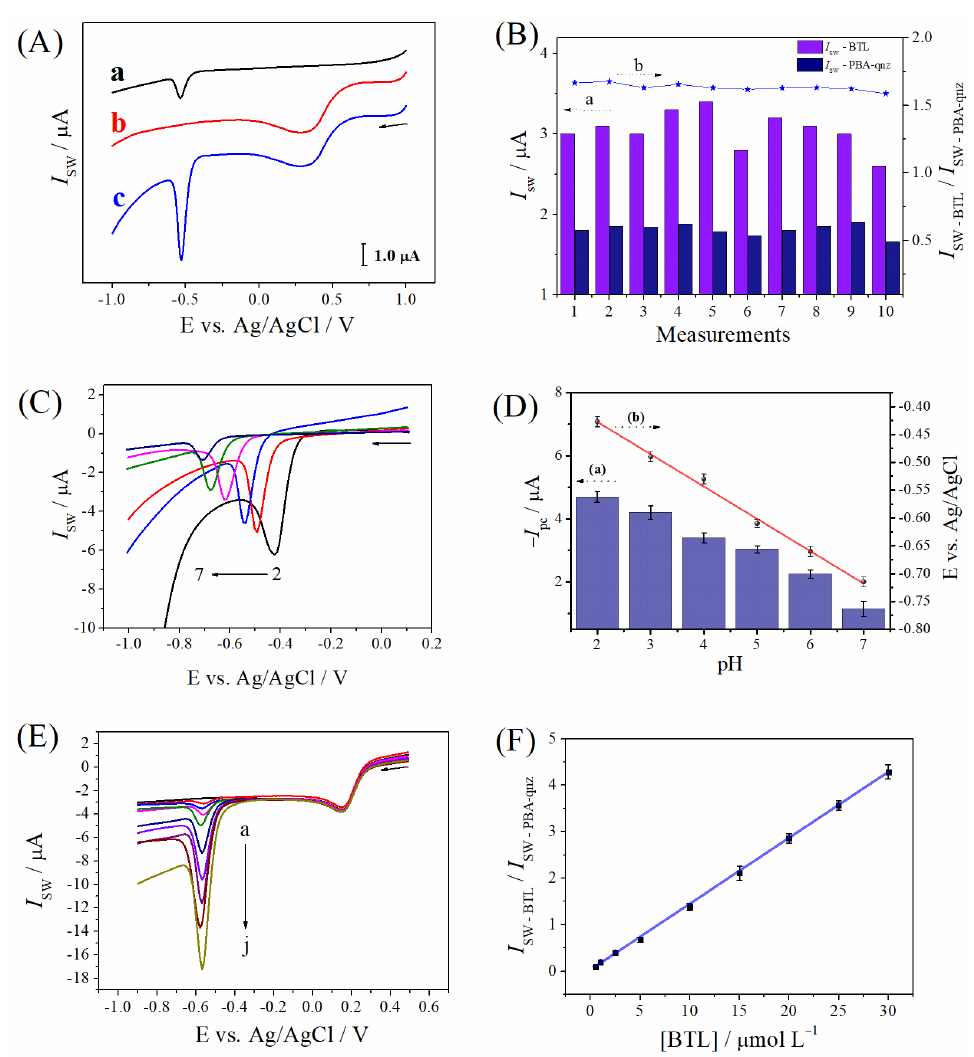
Figure 4. ( A ) Square wave voltammograms in the absence of BTL for (b) PBA-qnz/CPE in buffer solution and in the presence of 10.0 μmol L −1 BTL in B – R buffer (pH 2.0) for (a) CPE and (c) PBA-qnz/CPE. SWV parameters: f = 25.0 Hz, ΔEs = 1.0 mV, a = 50.0 mV (nonoptimized). ( B ) Current responses for I SW − BTL and I SW − PBA-qnz (axis a) and the I SW − BTL / I SW − PBA-qnz ratio (axis b) using the same PBA-qnz/CPE on the same day. ( C ) Square wave voltammograms for 10.0 μmol L −1 BTL in B – R buffer using the PBA-qnz/CPE at different pH values. ( D ) Current (axis a) and potential (axis b) vs. pH ( n = 3). ( E ) Square-wave voltammograms for BTL at PBA-qnz/CPE in 0.1 mol L −1 B – R buffer (pH 2.0): (a) blank, (b) 0.5, (c) 1.0, (d) 2 .5, (e) 5.0, (f) 10.0, (g) 15.0, (h) 20.0, (i) 25.0, and (j) 30.0 μmol L −1 and ( F ) calibration plot ( n = 3). SWV parameters: f = 50.0 Hz, ΔEs = 2.0 mV, a = 60.0 mV (optimized).